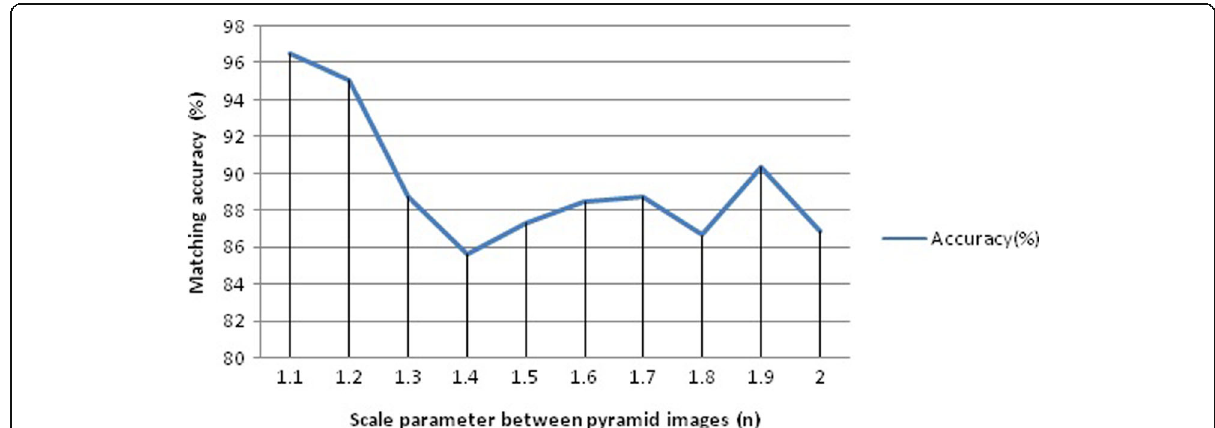
Fig. 13 Relationship between scale parameter variation and feature detection accuracy of pyramid images